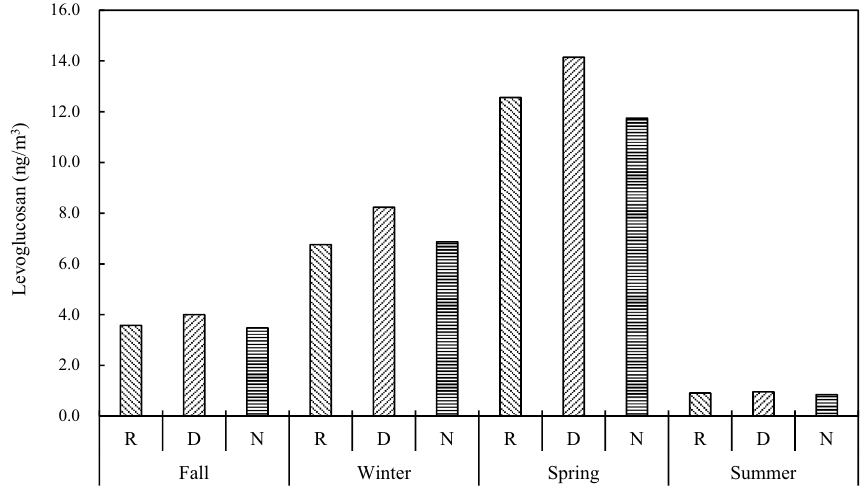
Figure 8. Seasonal variation of levoglucosan concentration in PM 2.5 sampled at the Taiping Island in the South China Sea (R: regular sampling; D: daytime; N: nighttime).